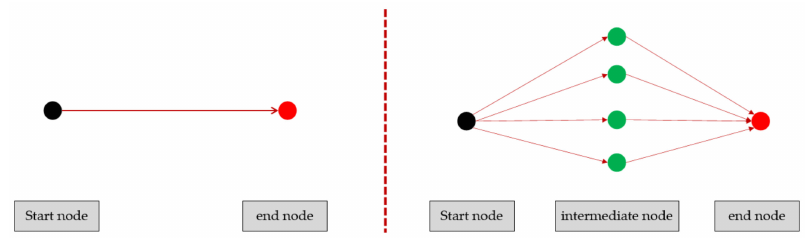
Figure 8. Extended A* Algorithm.